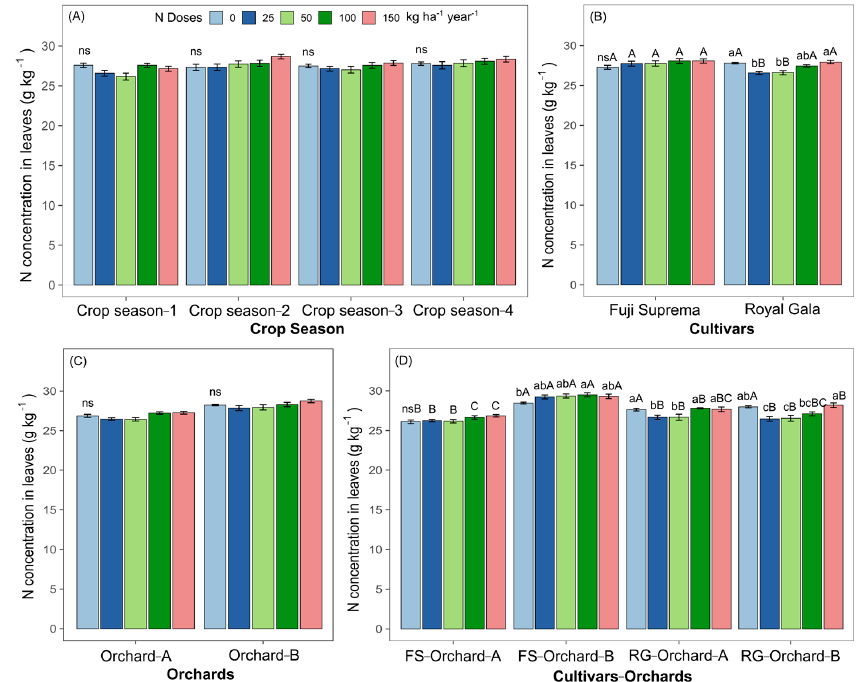
Figure 6. N concentration in apple leaves subjected to different N rates and their relationship with the factors “crop season” ( A ), “cultivar” ( B ), “orchard” ( C ), and the “cultivar * orchard” interaction ( D ). Lowercase letters compare the means of N doses within the same factor (crop season, cultivar, orchard and cultivar—orchard) and uppercase letters between factors using Tukey’s test. Differences were considered significant when p value < 0.05; ns: non-significant at p ≥ 0.05.